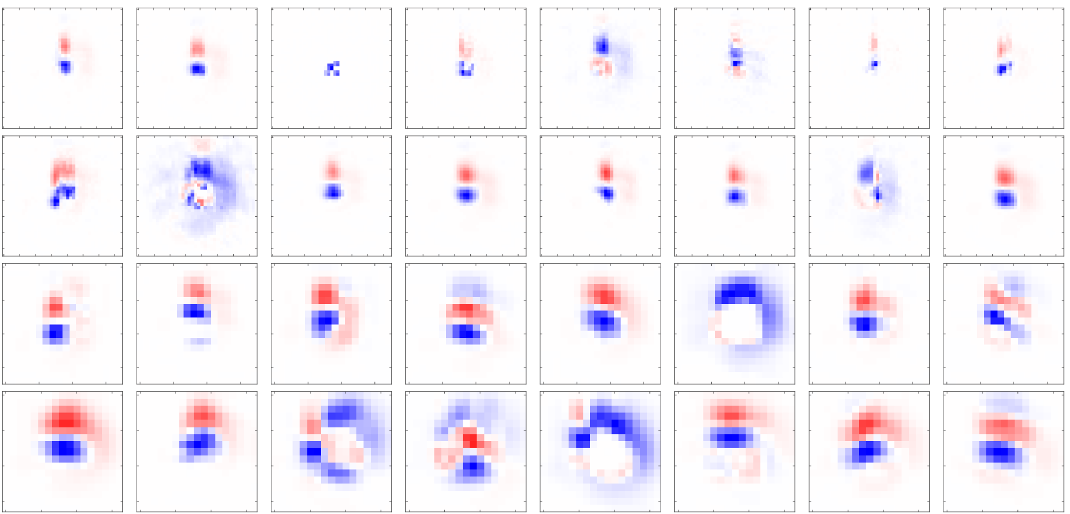
Figure 5 . Averaged signal minus background for our default network and full pre-processing. The rows correspond to ConvNet layers one to four. After two rows MaxPooling reduces the number of pixels by roughly a factor of four. The columns indicate the feature maps one to eight. Red areas indicate signal-like regions, blue areas indicate background-like regions.